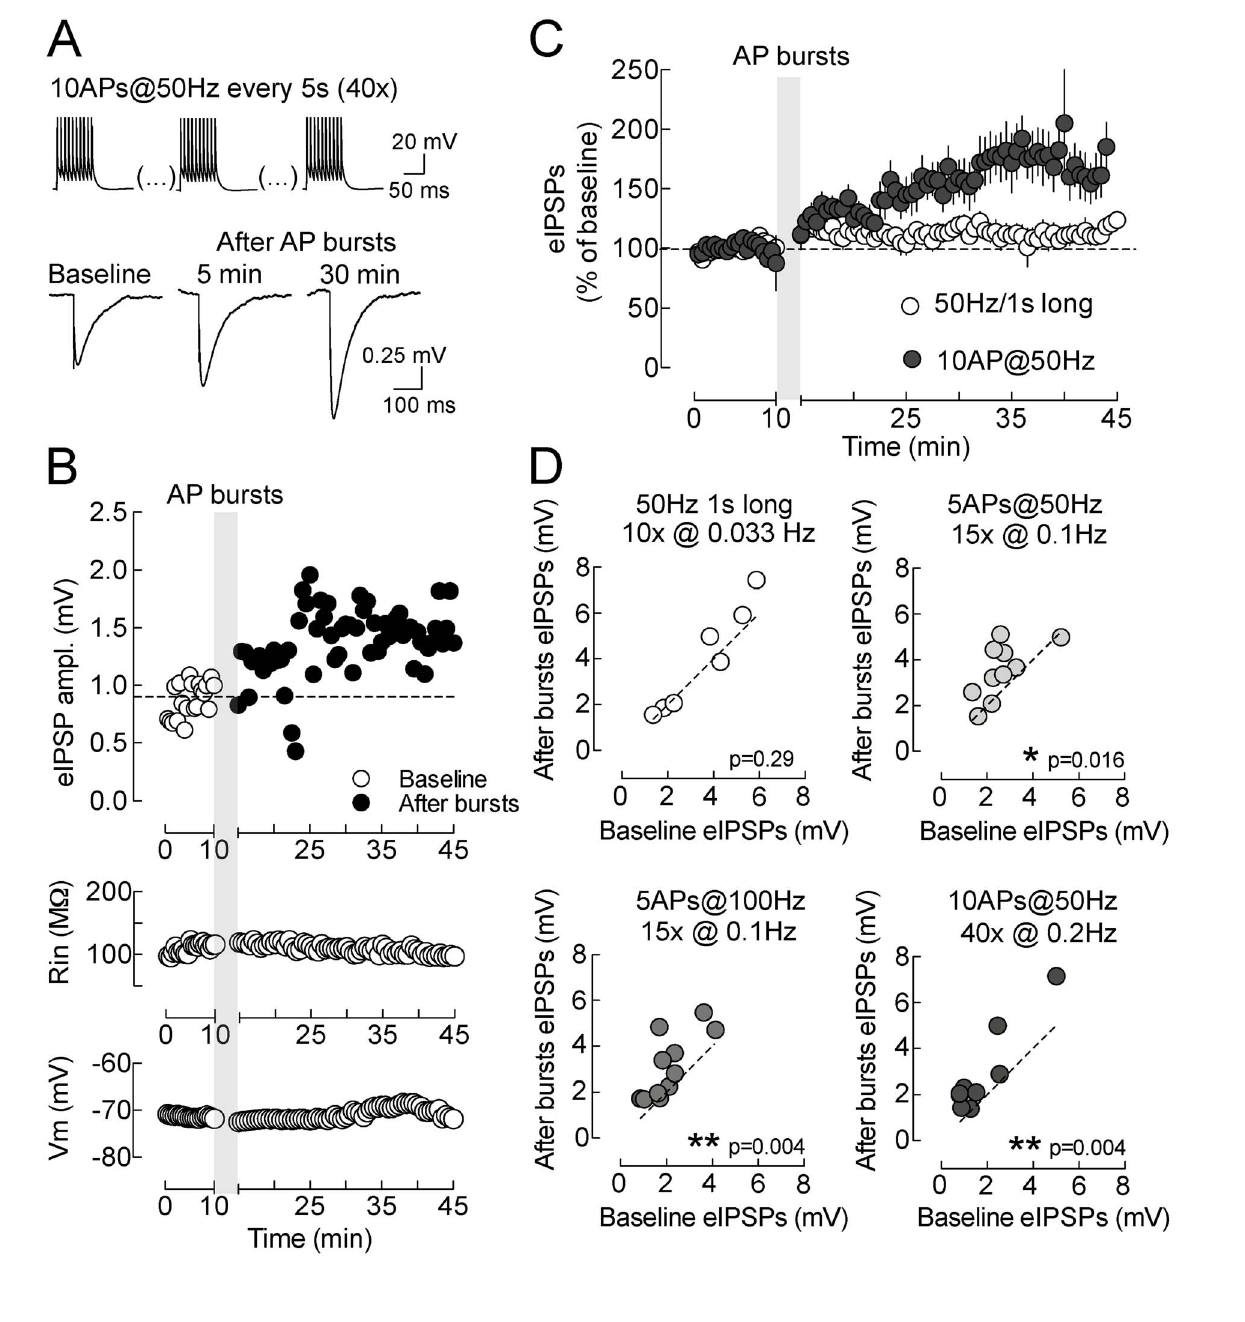
Figure 2. Postsynaptic AP firing efficiently induces LTPi. (A) Representative current-clamp traces of eIPSPs in the presence of intracellular physiological [Cl 2 ] in continuous presence of DNQX (10 m M). A clear LTPi is observed 30 min after postsynaptic AP bursts (Top). (B) Time course of IPSPs (binned in 30-s intervals) in the neuron of (A) before (open circles) and after (solid circles) postsynaptic AP bursts. Input resistance (Rin, Middle) and resting membrane potential (Vm, Bottom) remained stable throughout the experiment. (C) Population time courses of normalized IPSPs in neurons firing long spike trains (open circles), showing no LTPi, and in neurons firing brief AP bursts (solid circles) expressing LTPi. (D) Plots of individual eIPSPs amplitude before ( x -axes) versus 20 min after AP bursts ( y -axes). LTPi could be induced by different burst firing paradigms (solid circles) but not long-lasting firing (open circles). Data refer to single values and/or mean 6 SEM. * p , 0.05; ** p , 0.001. doi:10.1371/journal.pbio.1001903.g002 plasticity of inhibition originating from PV-positive, fast-spiking interneurons, we used paired recordings between PV cells and (FS) basket cells, and SST-positive interneurons. The former pyramidal neurons (using PV-Cre::RCE mice, Figure 3C–E; see target the perisomatic region of pyramidal neurons, whereas Materials and Methods [18,19]). Conversely, to selectively activate the latter target the distal portion of their apical dendrites [15,17]. SST-cell IPSCs, we expressed the light-activated channel chan- To identify GABAergic transmission originating from PV nelrhodopsin 2 (ChR2) using viral vectors in SST-Cre mice (see